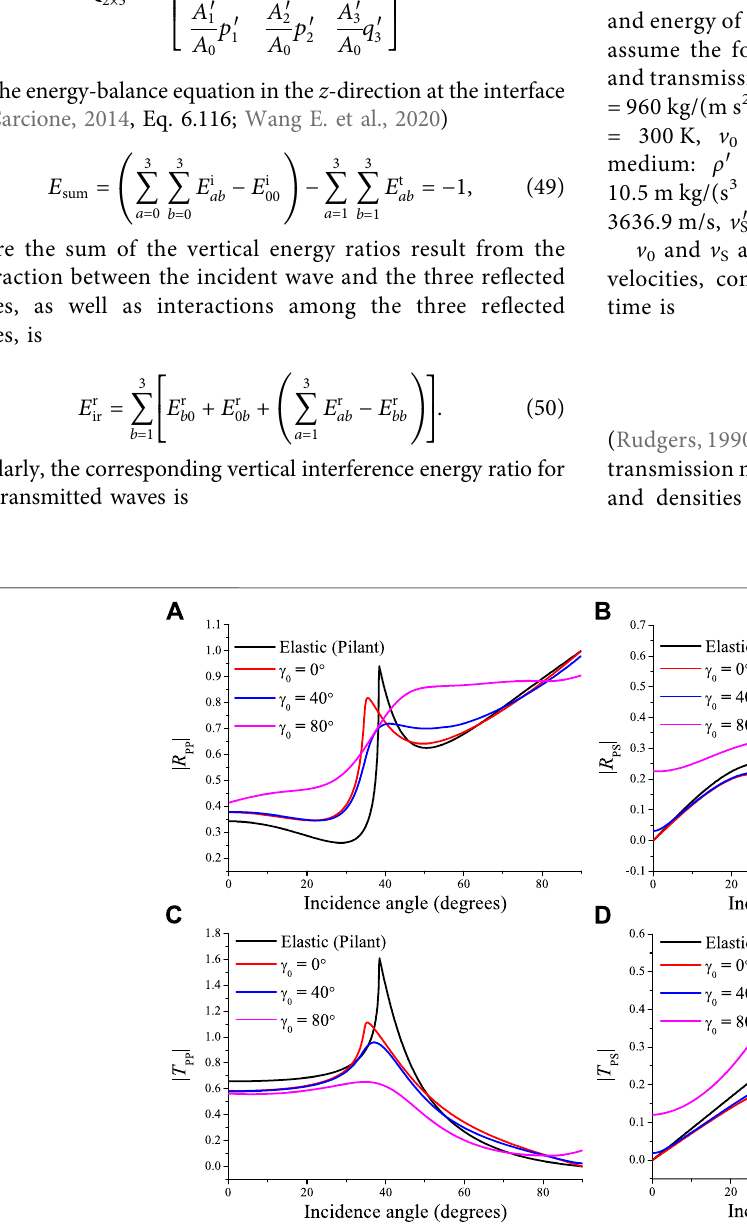
Frontiers in Earth Science |